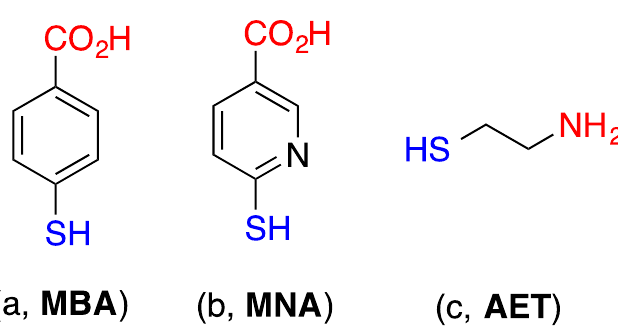
Figure 2. Chemical modification of gold-coated cantilever surface with: 4-mercaptobenzoic